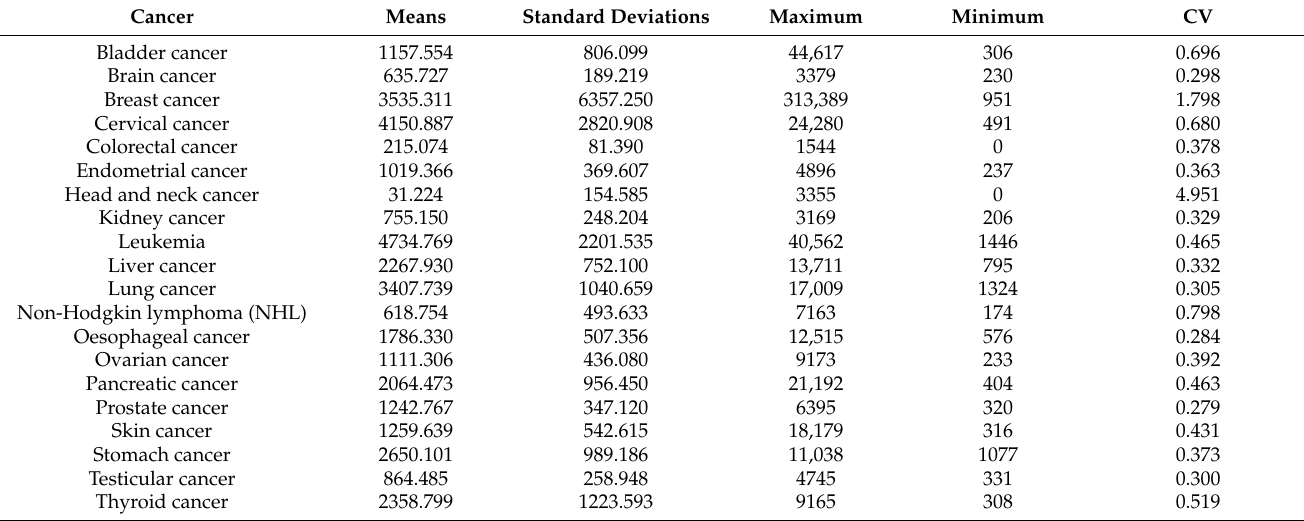
Table 1. Descriptive information of 20 cancers’ Baidu Search